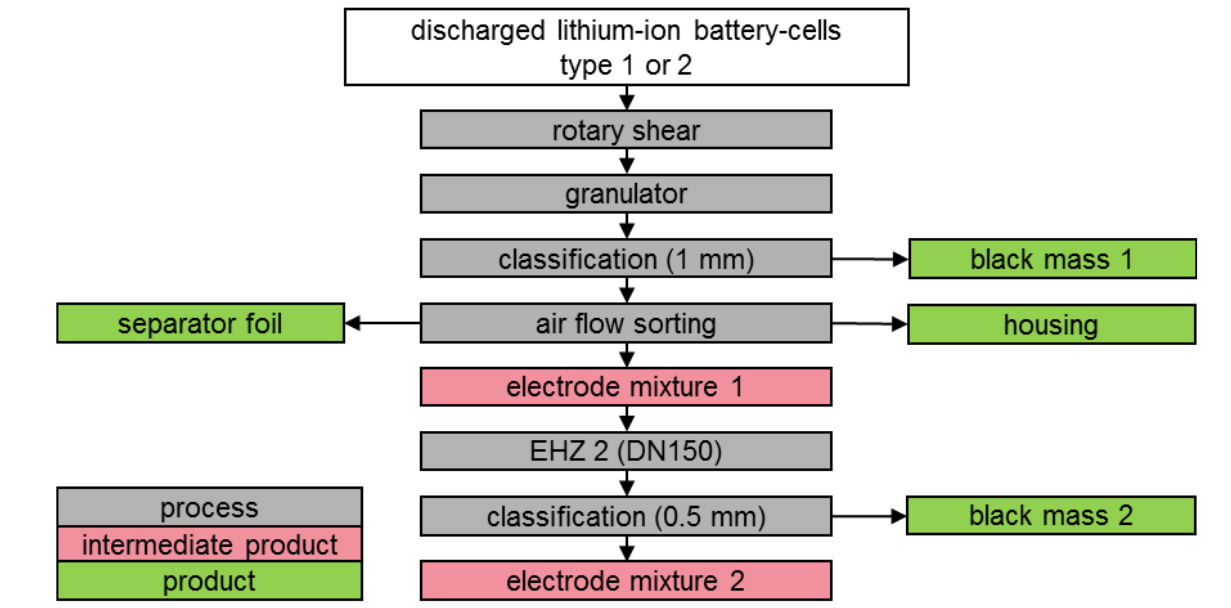
Figure 5. Schematic illustration of test series 2.